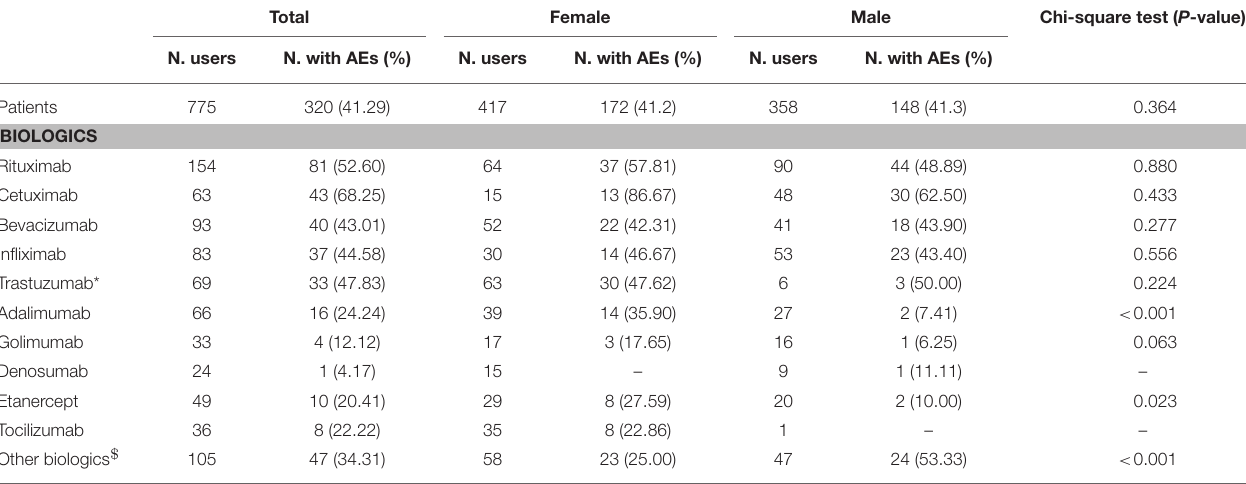
TABLE 2 | Distribution of patients with at least 1 adverse event (AE) by gender and type of biotech